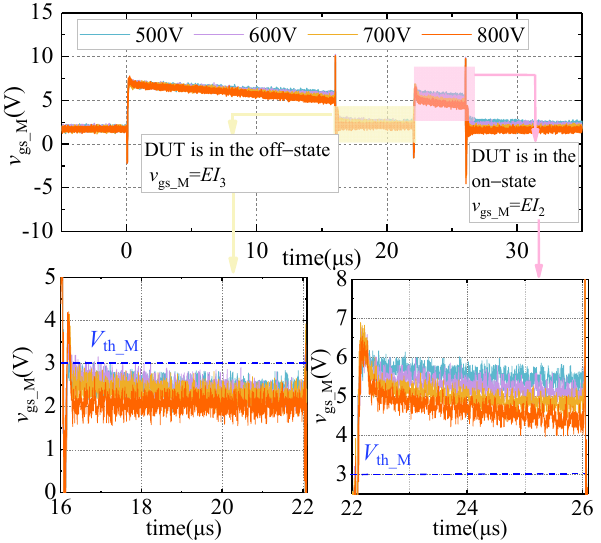
Figure 11. The gate-source voltage waveform of M under different voltages ( V cc = 7 V, V D3 = 7.5 V).